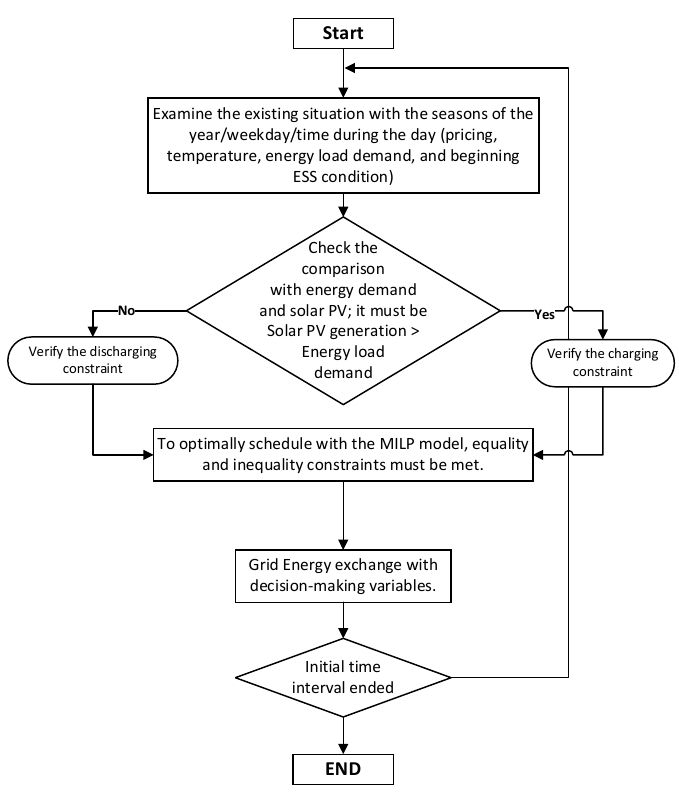
Figure 3. Proposed solution methodology flowchart.